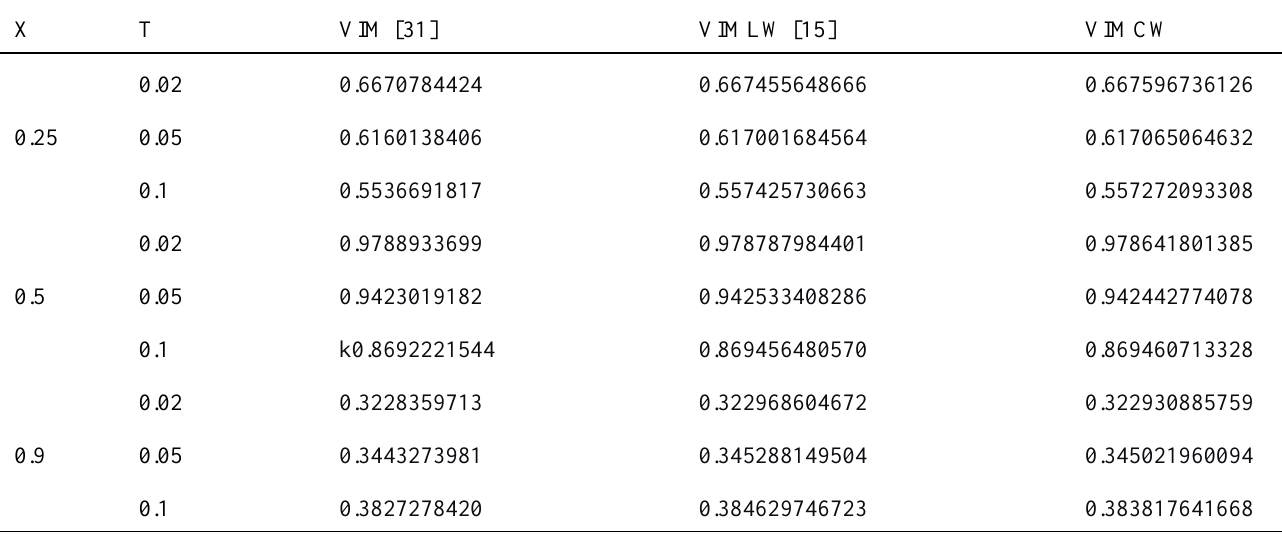
Analysis of the computed solution with different parameters, when 𝛼 = 𝛽 = 1, 𝛾 = 0.9 and for 𝜀 =